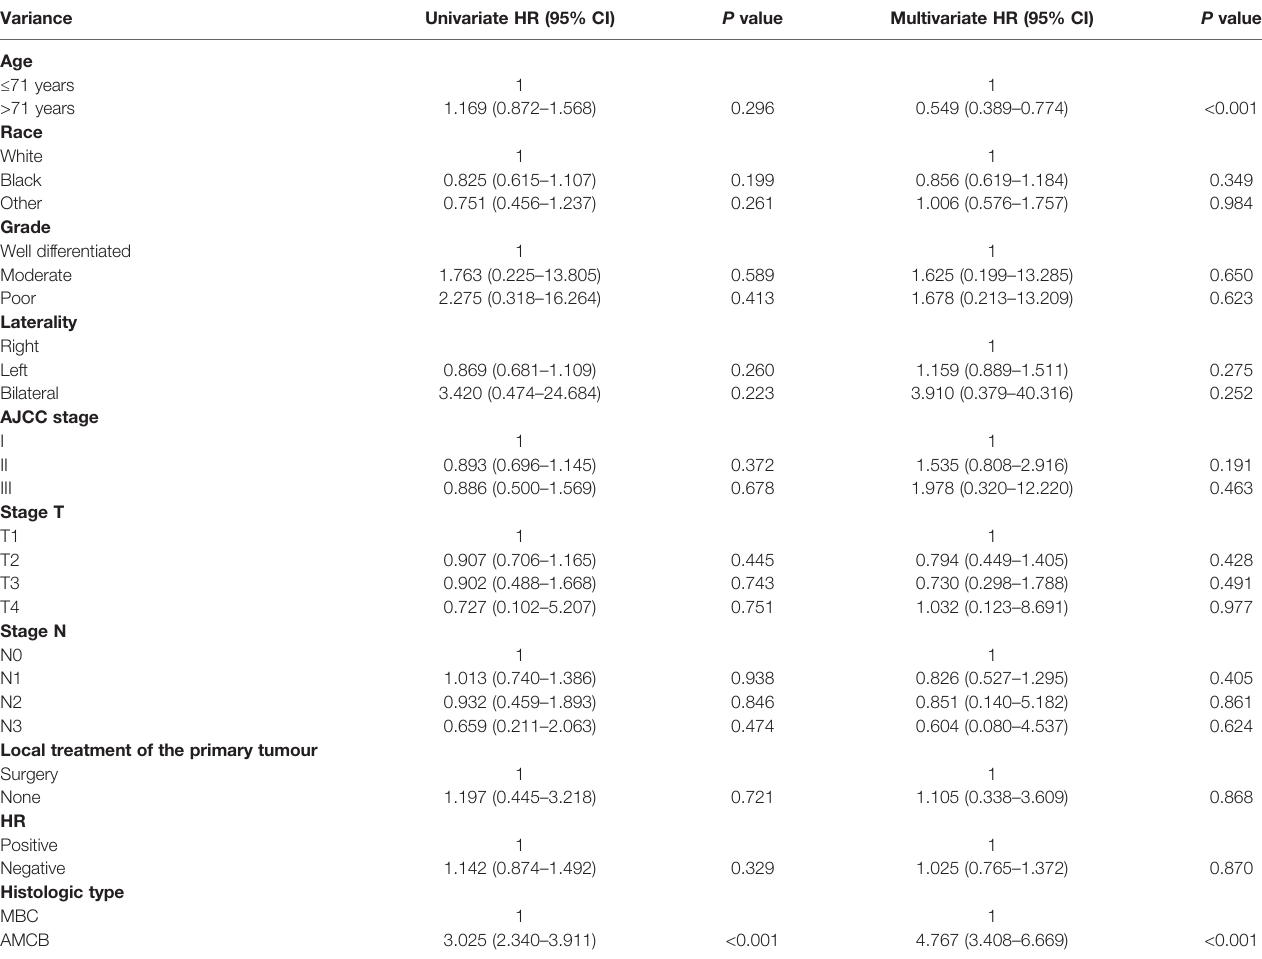
TABLE 4 | Univariate and multivariate Cox proportional hazard analyses of the association of clinical characteristics with overall survival rates in patients with AMCB and MBC after propensity score matching.